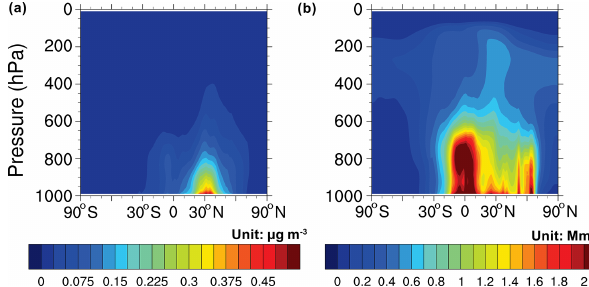
Figure 13. Global zonal mean distributions of (a) BC mass concen- trations (µgstdm − 3 ; mass concentration under standard conditions) and (b) BrC absorption at 365nm (Mm − 1 ) for 2010.